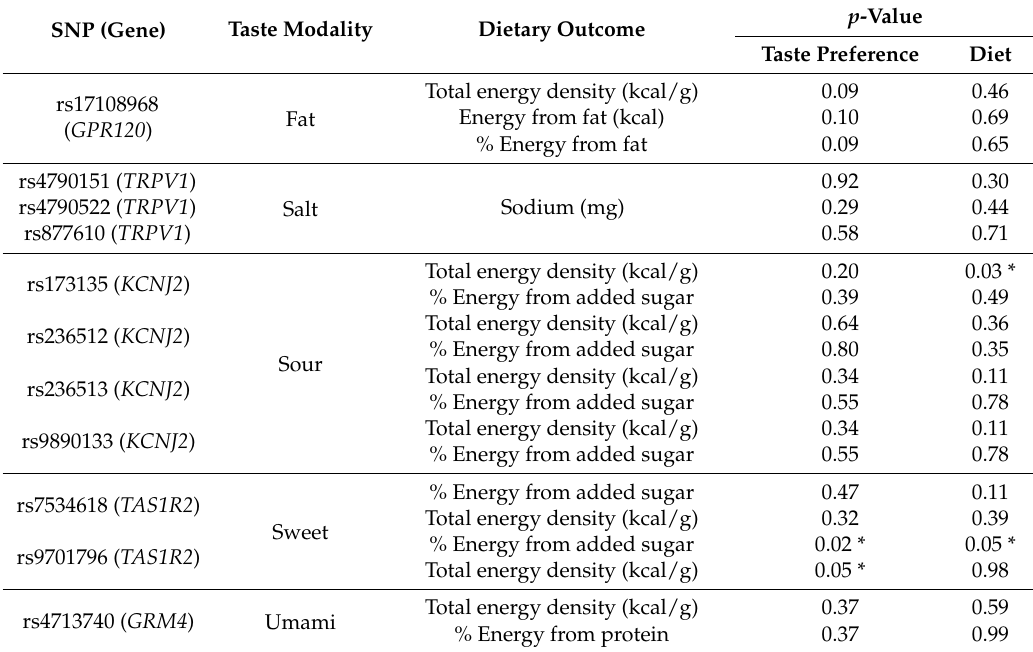
Table 6. Multiple trait analysis of SNPs in taste receptor genes, taste preferences and dietary intake in